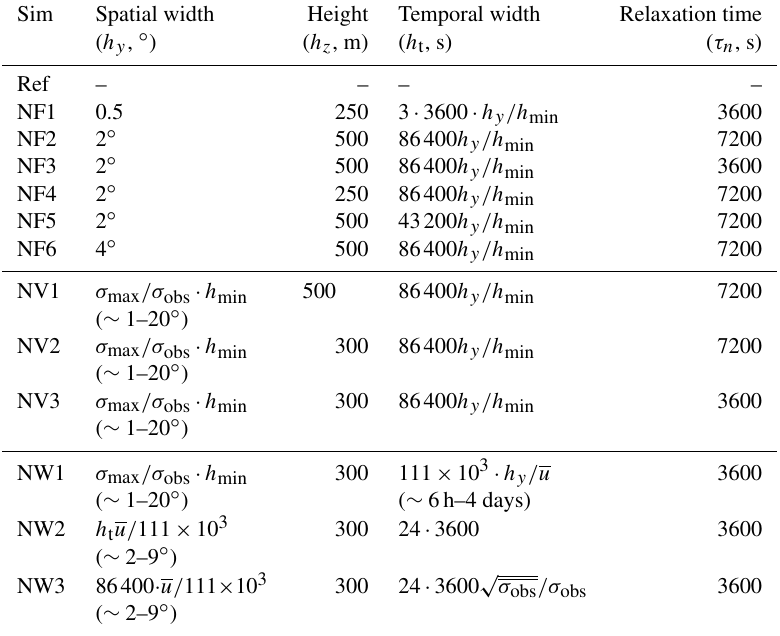
Table 1. Overview of kernel settings in the sensitivity analysis. The spatial width in the x direction is equal to the width in the y direction (in metres). σ obs is the standard deviation of observations over 1 year at each nudging location, σ max is the maximum value of σ obs from all nudging locations, h min is 1 ◦ and u is the mean wind speed at the nudging location based on ERA-Interim data. Sim Spatial width Height Temporal width – –